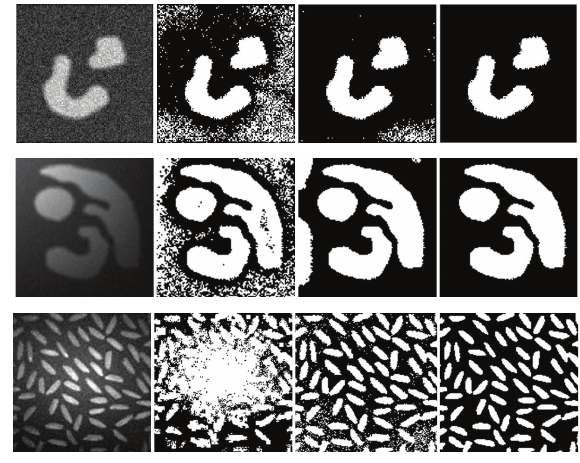
Figure 3: Segmentation results of the proposed algorithm on three synthetic images. Column 1: original images. Column 2-3: interme- diate results. Column 4: final